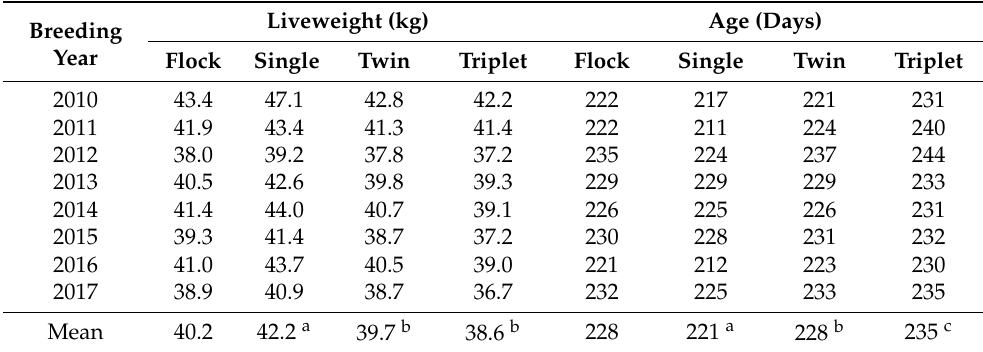
Table 2. Average liveweight and age at breeding for the whole flock and single-, twin- and triplet-born maternal composite ewe lambs from 2010 to